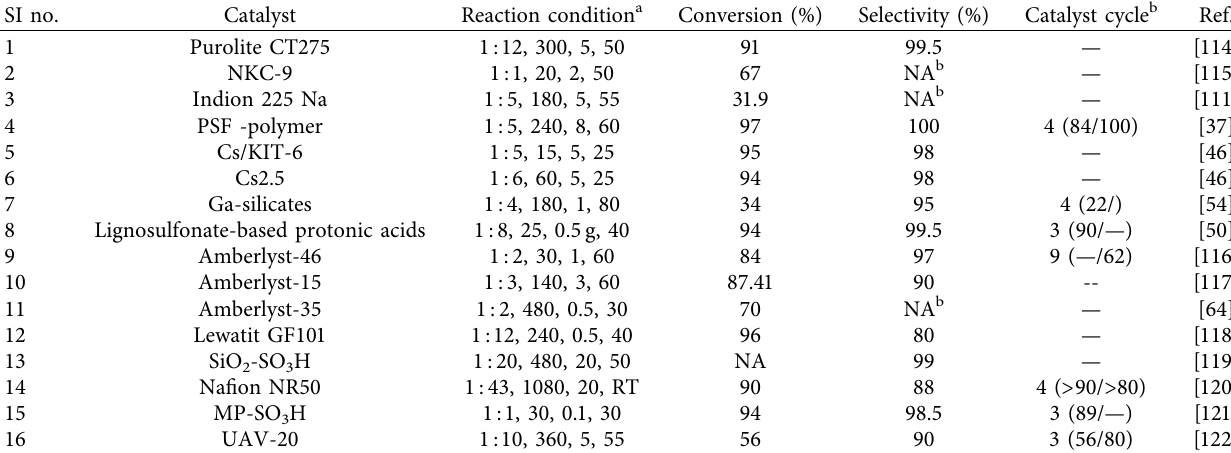
Table 4: Ion-exchange resins for solketal